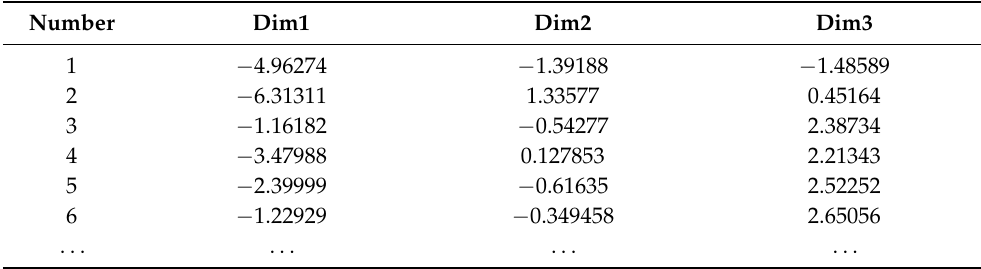
Table 4. Vibration eigenvalues after dimensionality